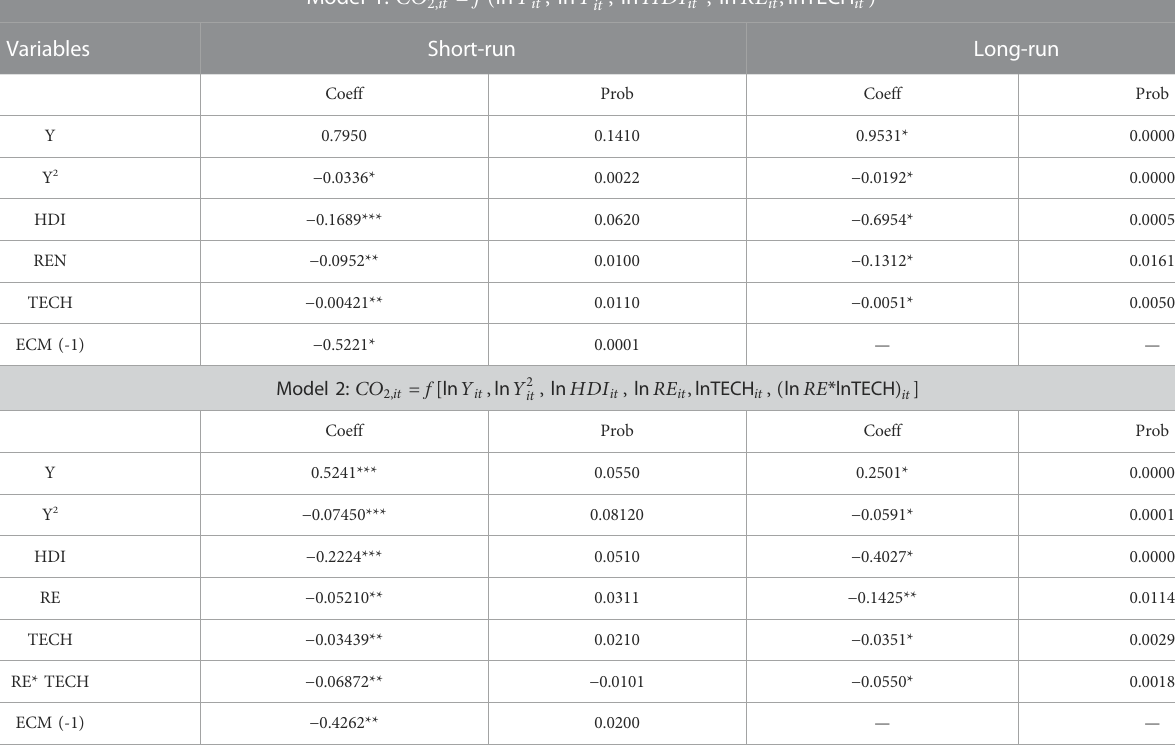
TABLE 7 Findings of CS-ARDL